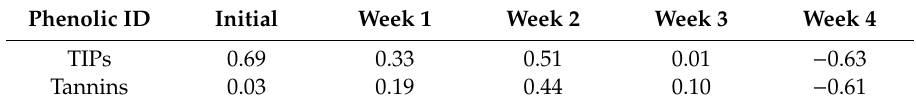
Table 3. Comparison of correlations between values obtained by assay between anthocyanins and total iron reactive phenols (TIPs) as well as between anthocyanins and tannins. By the fourth week, there was a significant negative correlation between anthocyanins and the other two phenolics and between anthocyanins and tannins, suggesting pigmentation. Assay data used to calculate correlation coe ffi cients were a subset of that used for modeling (n =